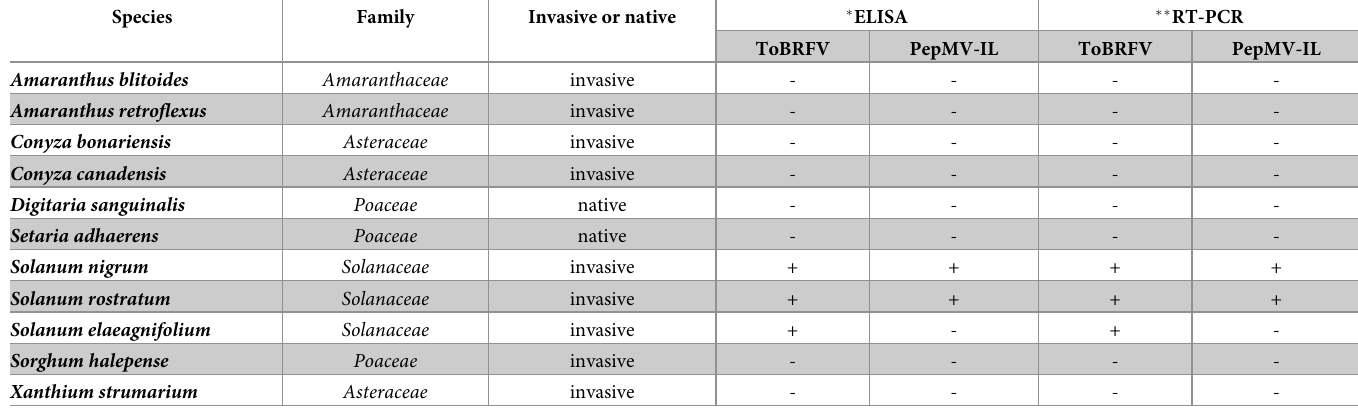
Table 1. Susceptibility of invasive and native weed species to ToBRFV and PepMV-IL infections.